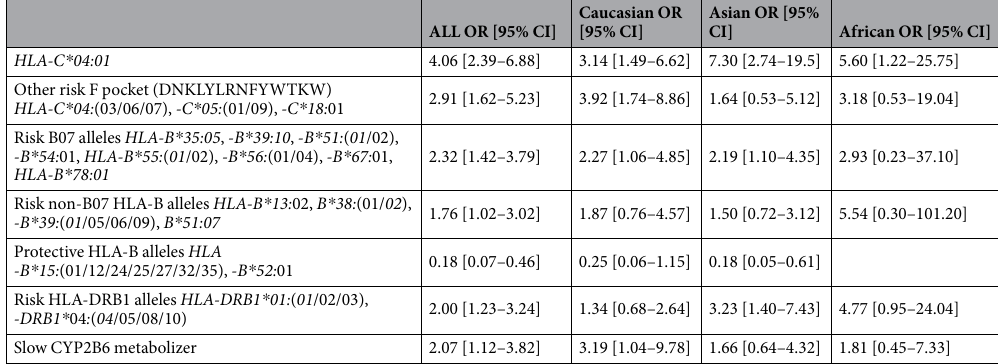
Table 2. Multivariate logistic regression model of predisposition to cutaneous NVP HSR, according to ancestry. All models have been adjusted for ethnicity as